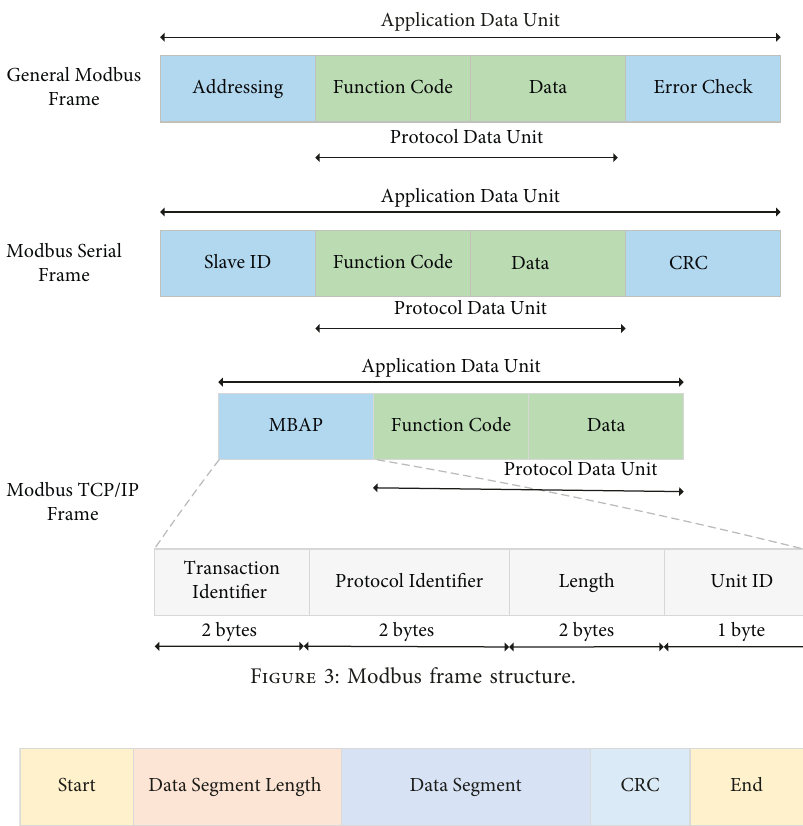
Figure 4: Structure of the data frame of the DCS and RMC communication.